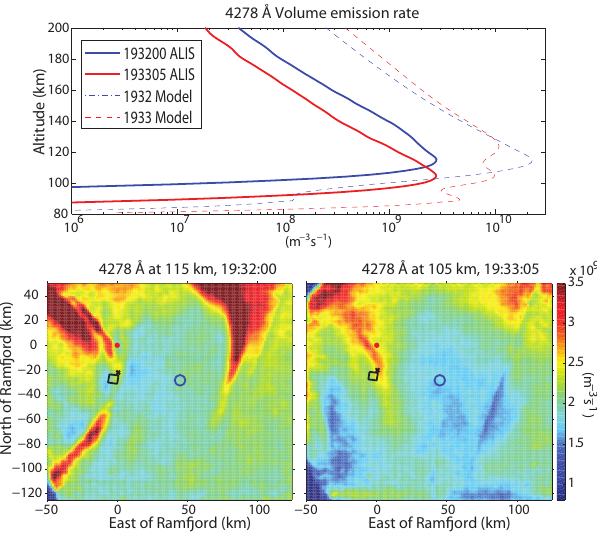
Fig. 9. Top panel: altitude profiles of the volume emission rates of the N + 2 (1,0) band derived from ALIS tomography data (solid lines), for the 1932 (blue) and 1933 (red) arcs, respectively. The modelled volume emission rates are shown as dashed lines. Bottom panels: Horizontal cuts for the narrow arcs at 19:32 UT and 19:33 UT.